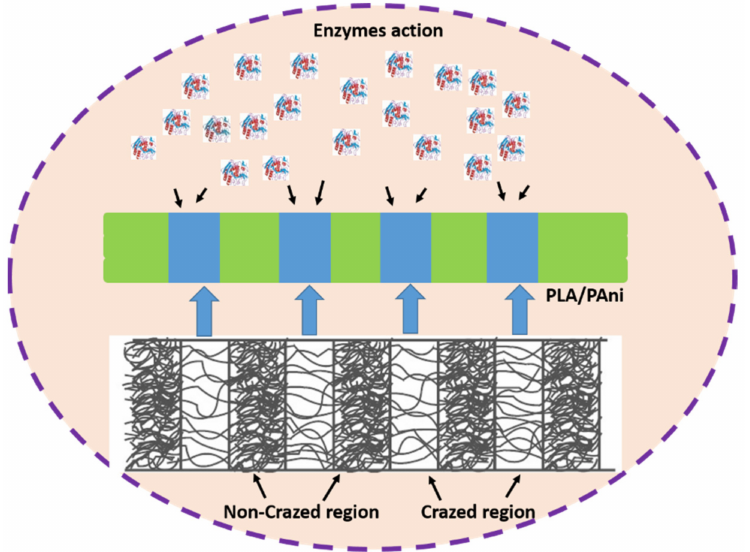
Figure 8. The diffusion of the enzyme in the crazed PLA/PAni